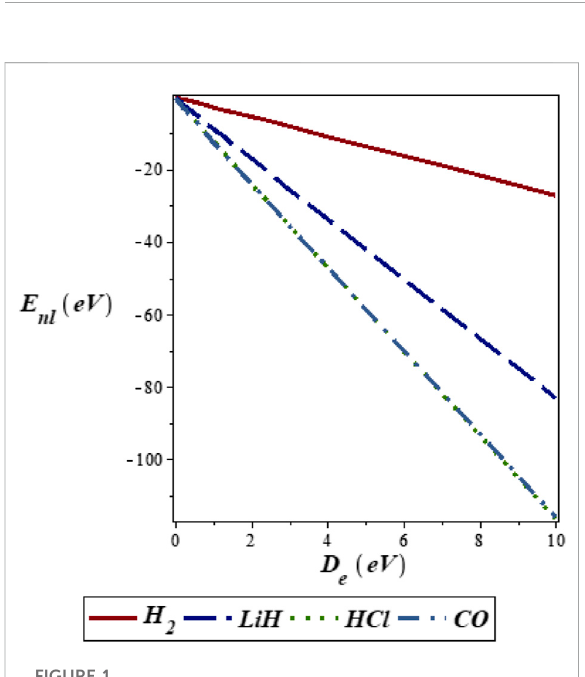
FIGURE 1 Variation of energy eigenvalues of the SSKP with dissociation energyfordifferentdiatomicmoleculesystemswith n =2and l =1.